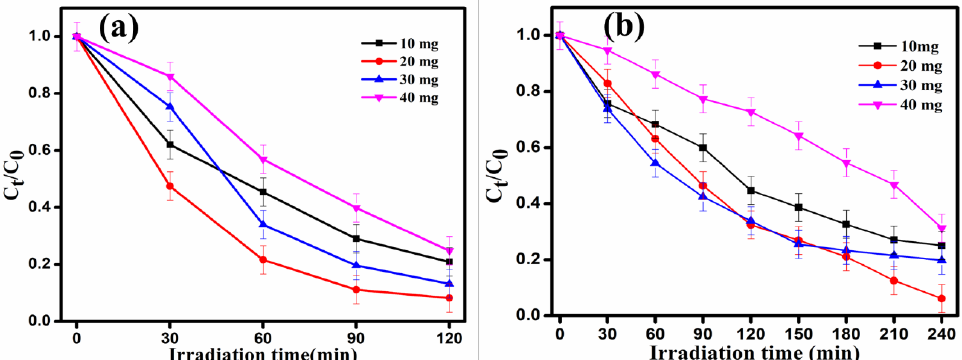
Figure 7. Influence of photocatalyst loading on photodegradation efficiency of ( a ) NP (Conc. 4 × 10 −4 M) and ( b ) BPA (Conc. 2 × 10 −4 M) pollutants over CLMO catalyst at pH 7.